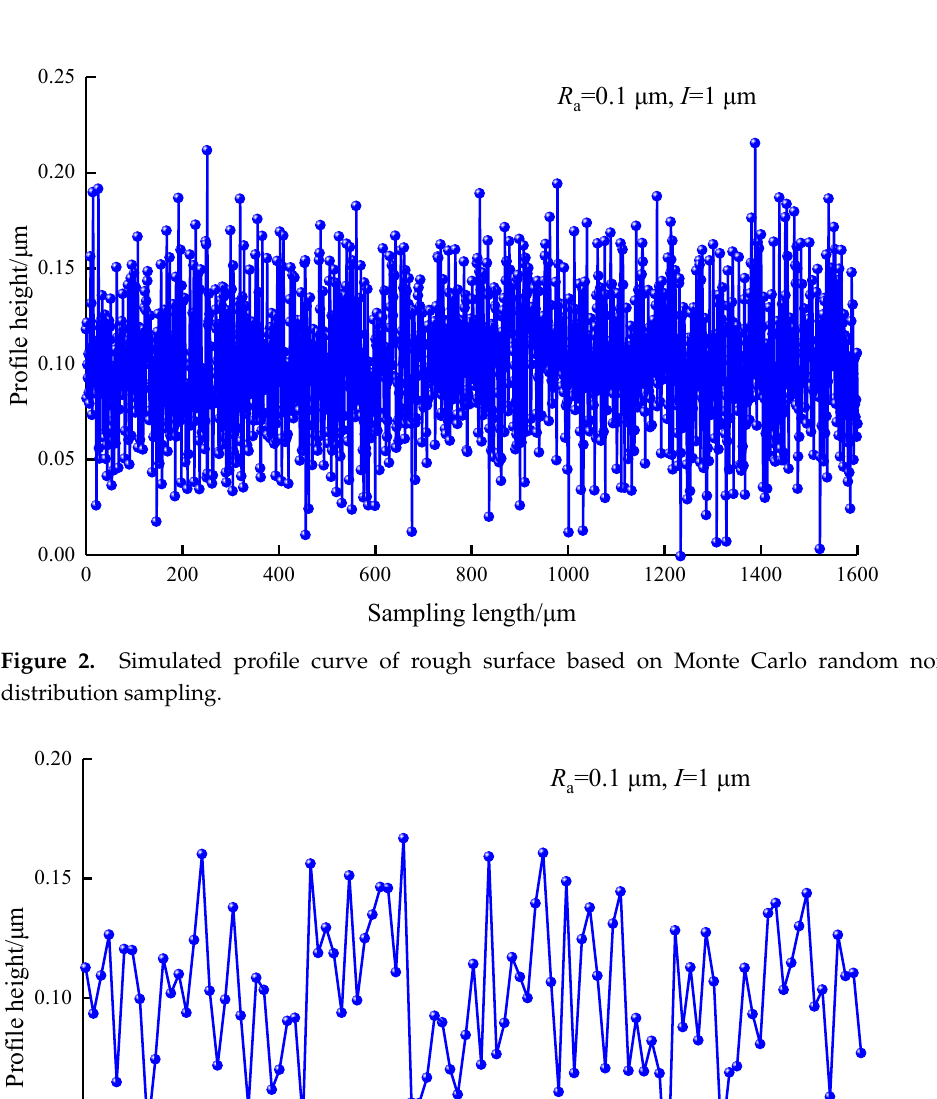
Figure 2. Simulated profile curve of rough surface based on Monte Carlo random normal distribu- tion sampling.